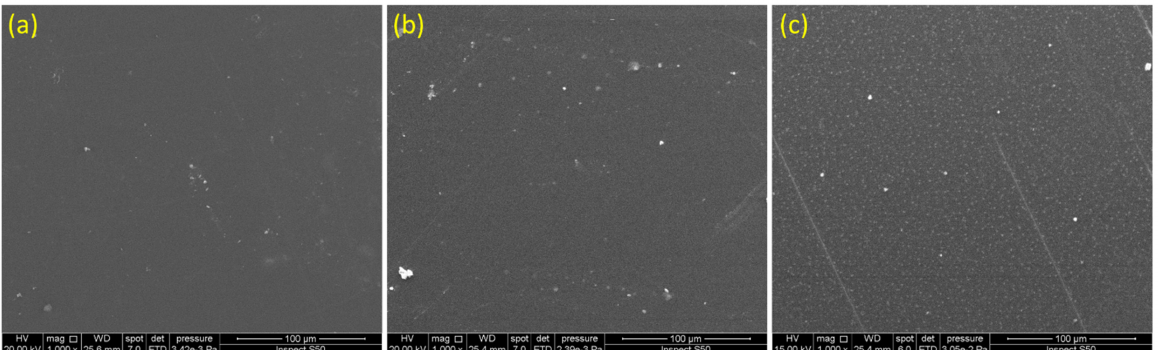
Figure 7. SEM images of pure PS film ( a ) before irradiation and ( b ) after 300 h of UV irradiation.